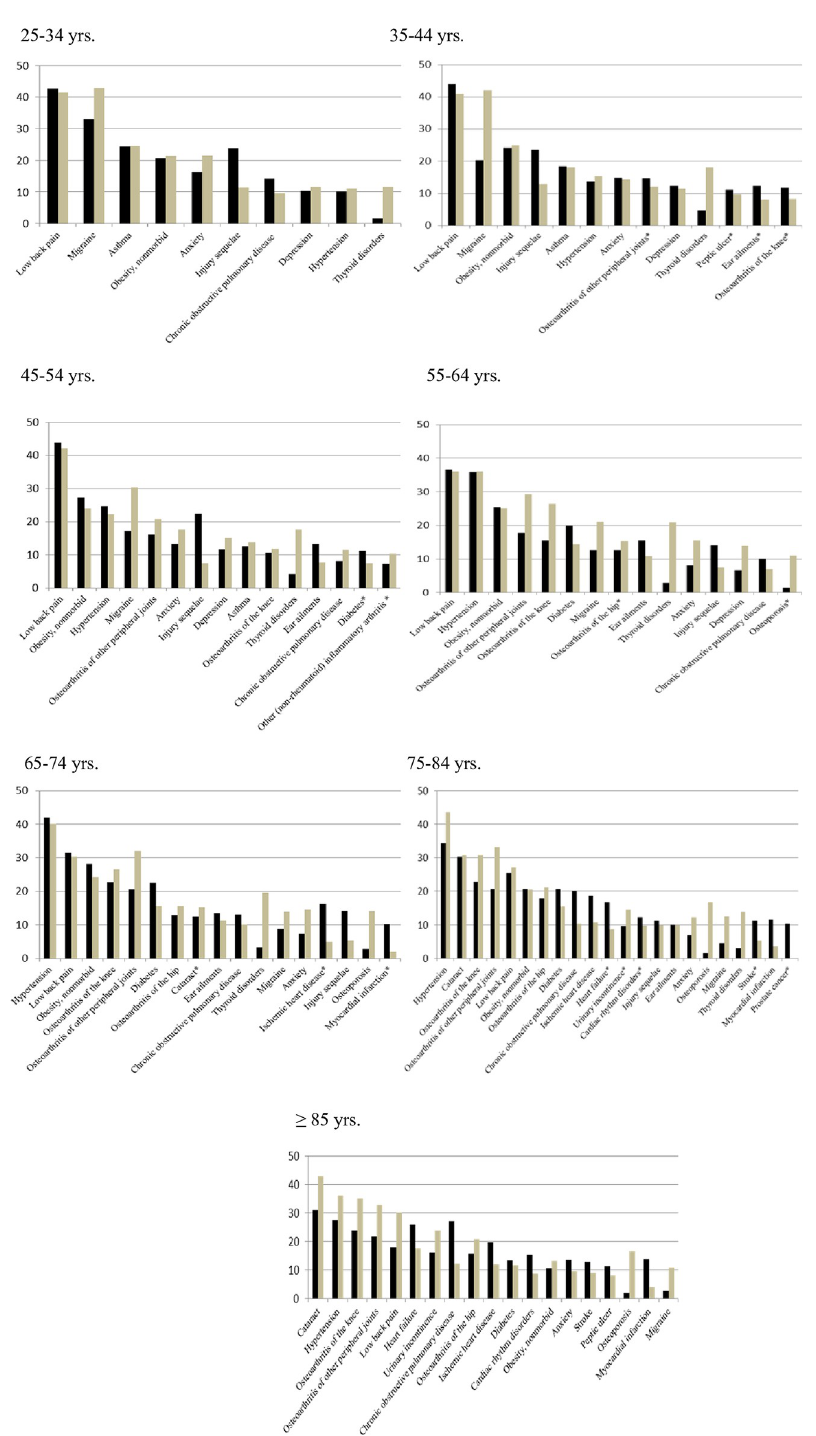
Fig 2. Top most frequent ( > 10%) conditions in the 14 gender and age groups of multimorbid subjects in the HSM survey. Ordinates represent frequencies in percentages. Conditions are ranked according to the median percentage of frequencies for both genders. Asterisk indicates a condition making its first entry in the top frequent ones at that age category.